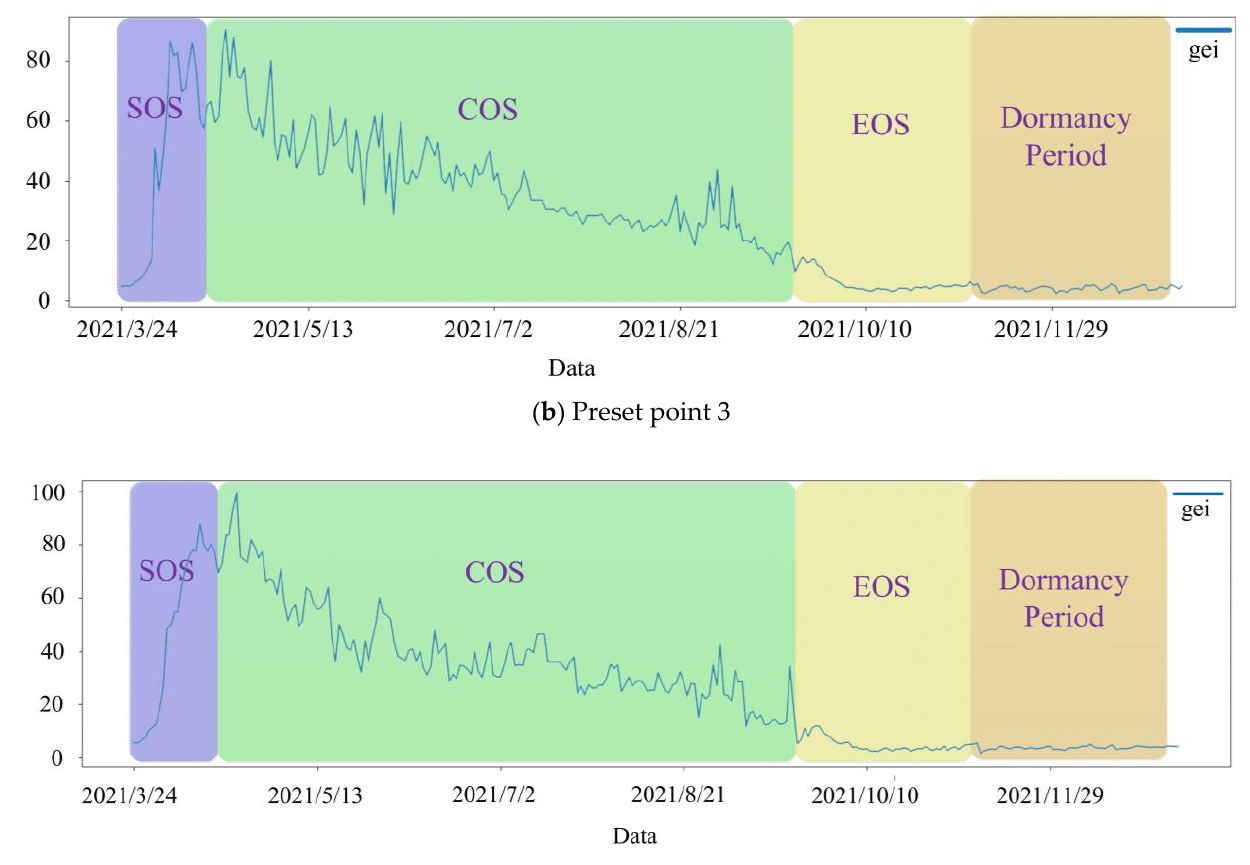
Figure 5. Growth